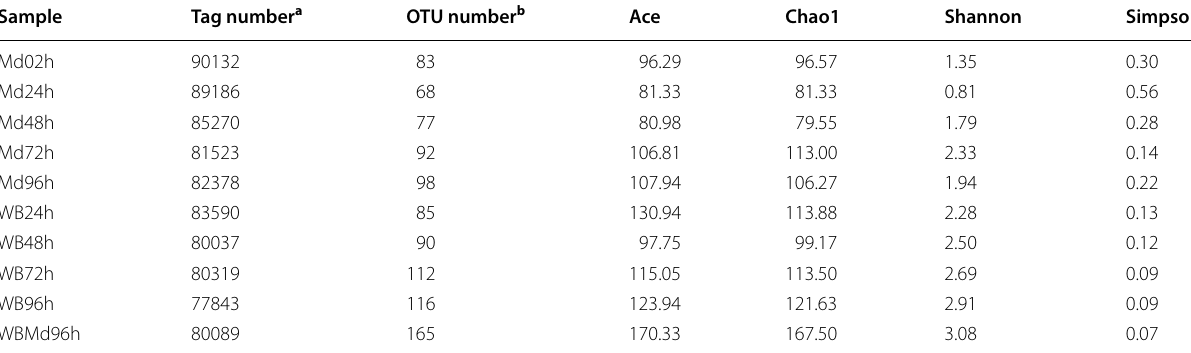
Table 1 Richness and diversity estimates of the 16S rRNA gene libraries from the sequencing analysis